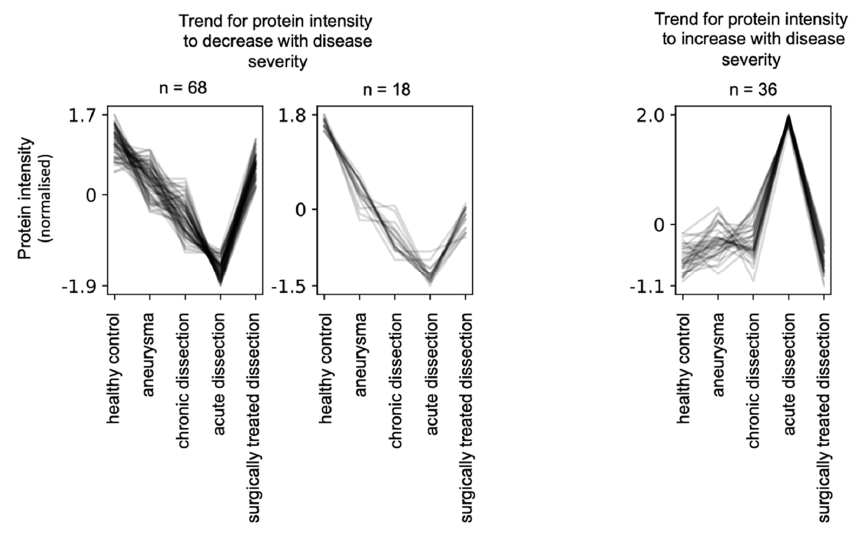
Figure 4. Clust analysis [18] to identify protein groups whose abundance negatively or positively correlated with disease severity together with partial reversal to healthy levels upon surgical treatment of aortic dissections. The clust algorithm determined quantile and z-score normalization as